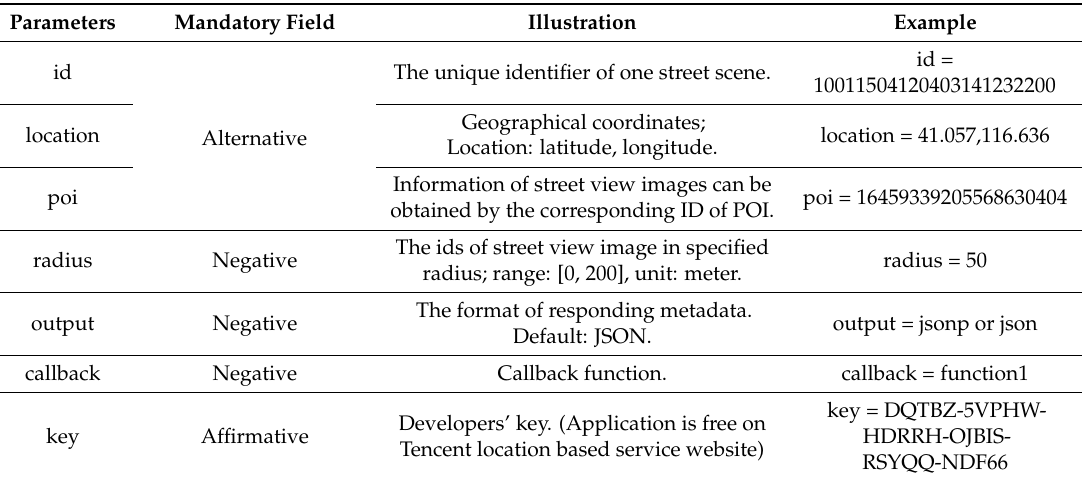
Table A1. Parameters of Tencent WebService